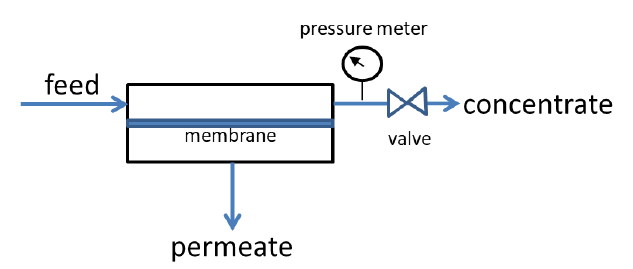
Figure 16. Simplified scheme of the water permeation setup.